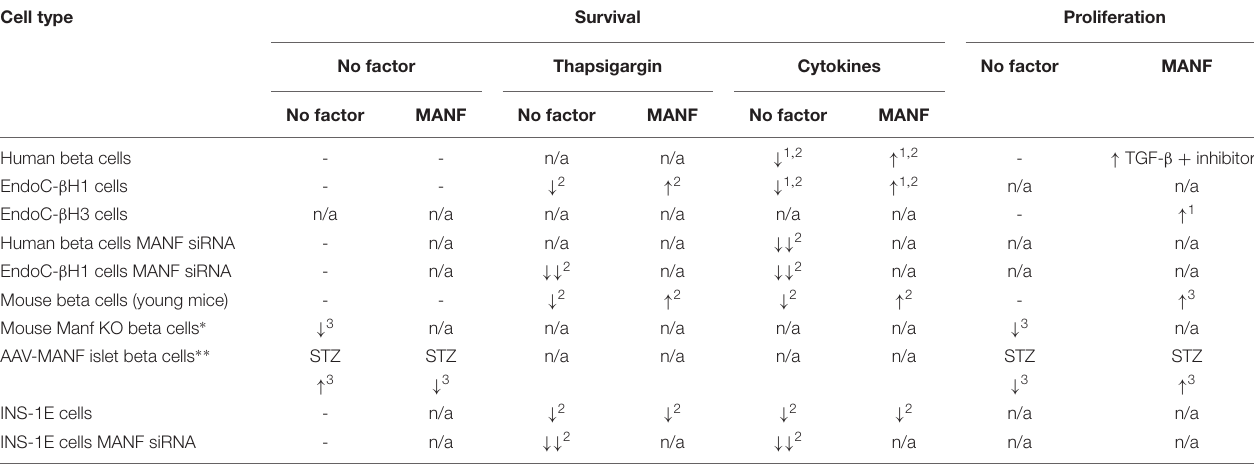
TABLE 1 | Survival and proliferation of beta cells. Cell type